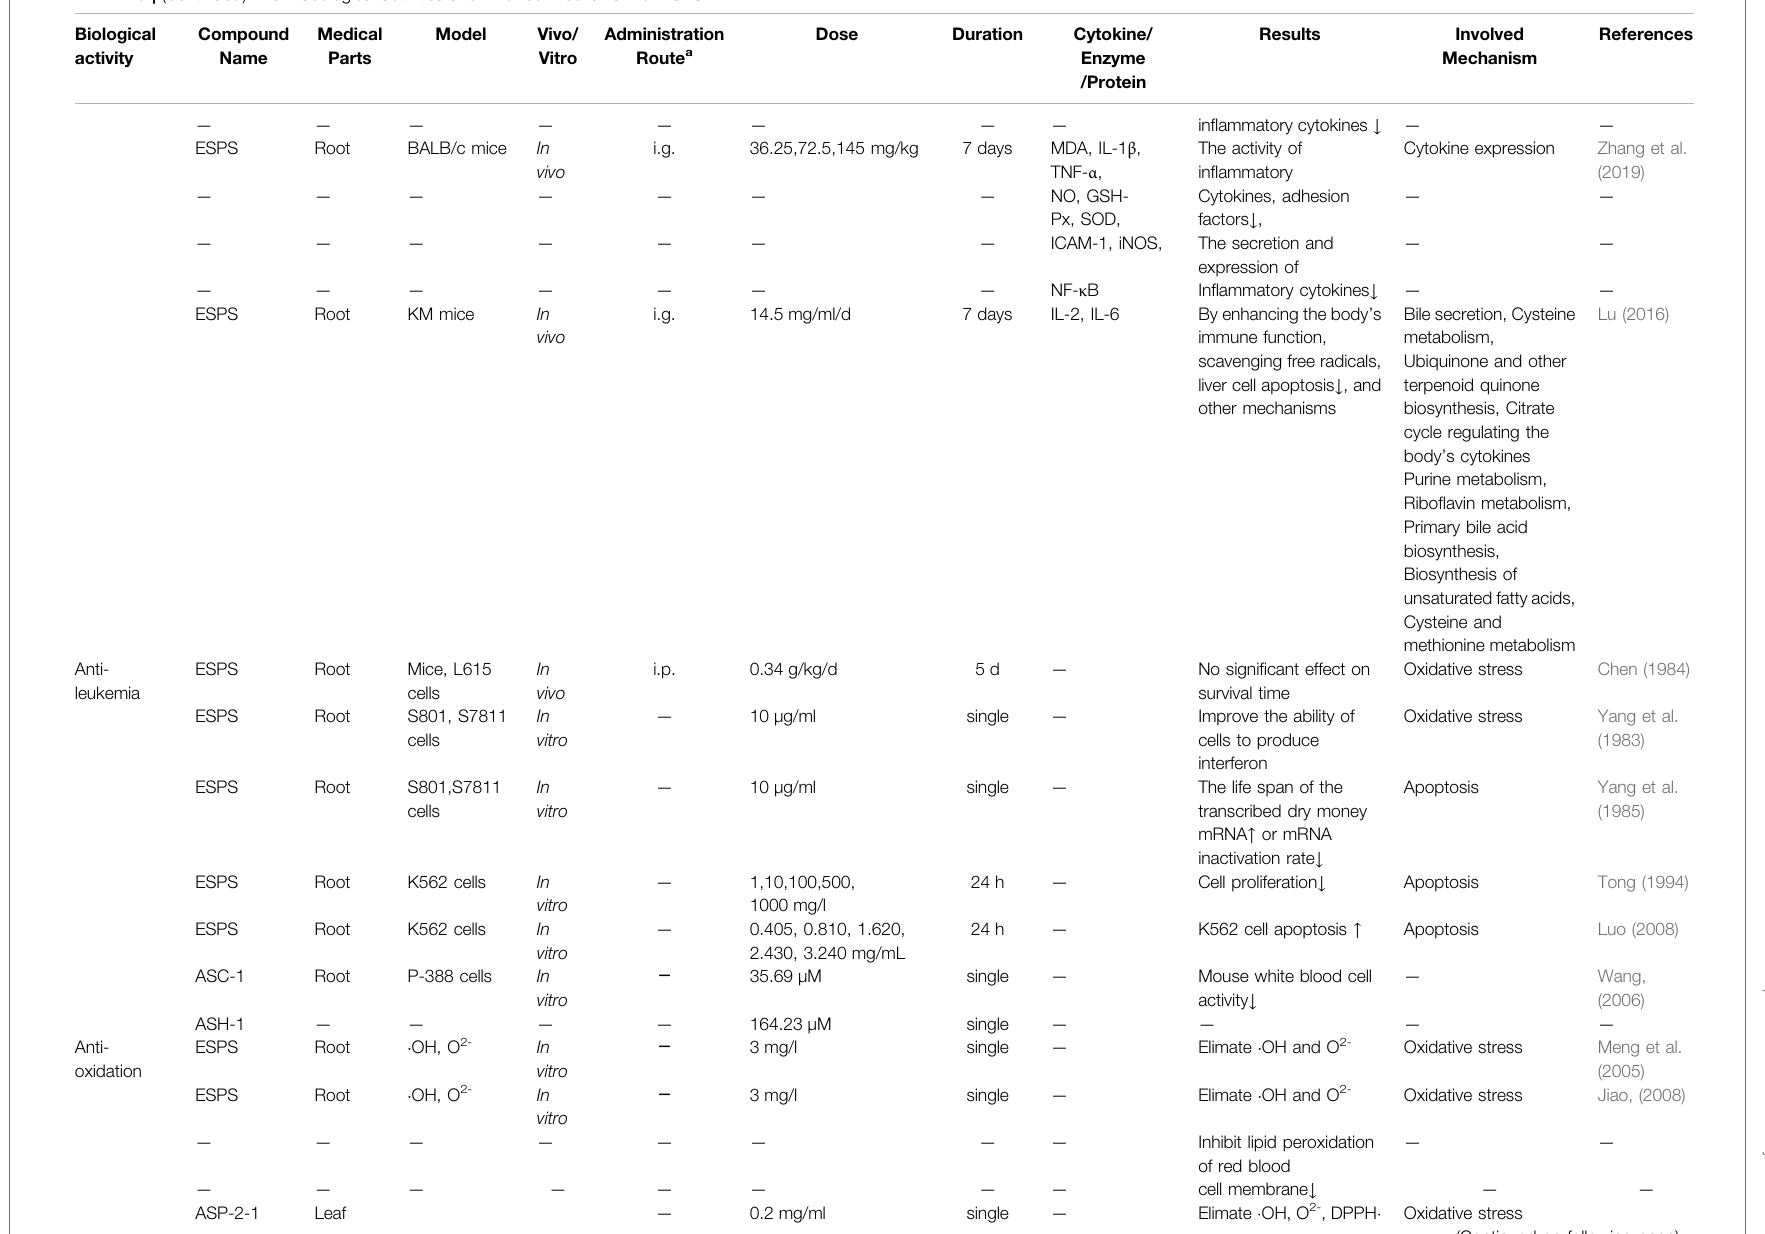
— — — — — — — — cell membrane ↓ — — Leaf — 0.2 mg/ml single — Elimate (cid:1) OH, O 2- , DPPH (cid:1) Oxidative stress